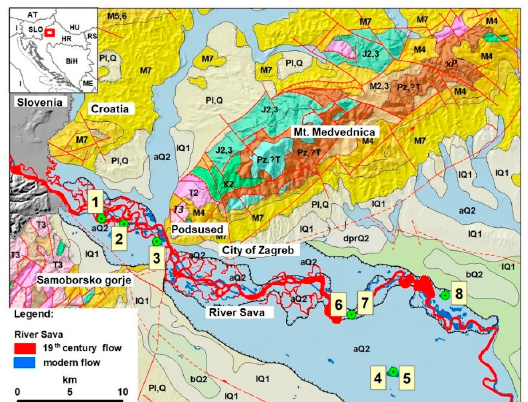
Figure 1. Geographical location and map of the study area. Sava River watercourses: non-regulated (red) and regulated (blue), sampling locations (green dots: 1–8): 1—Samobor; 2—Savrš ć ak; 3—Orešje;